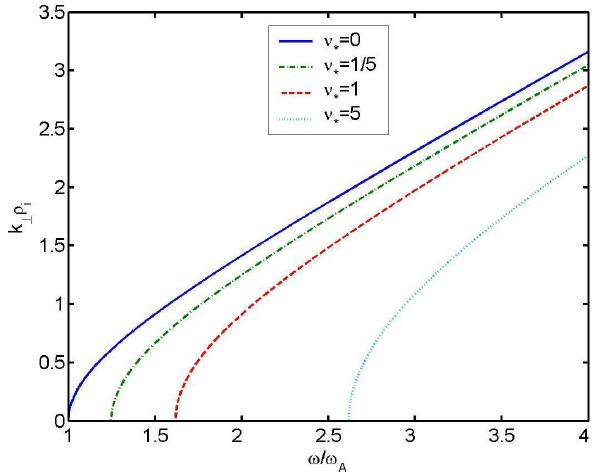
Fig. 2. The wave impedance normalized to the wave frequency. Other parameters are the same as in Fig.